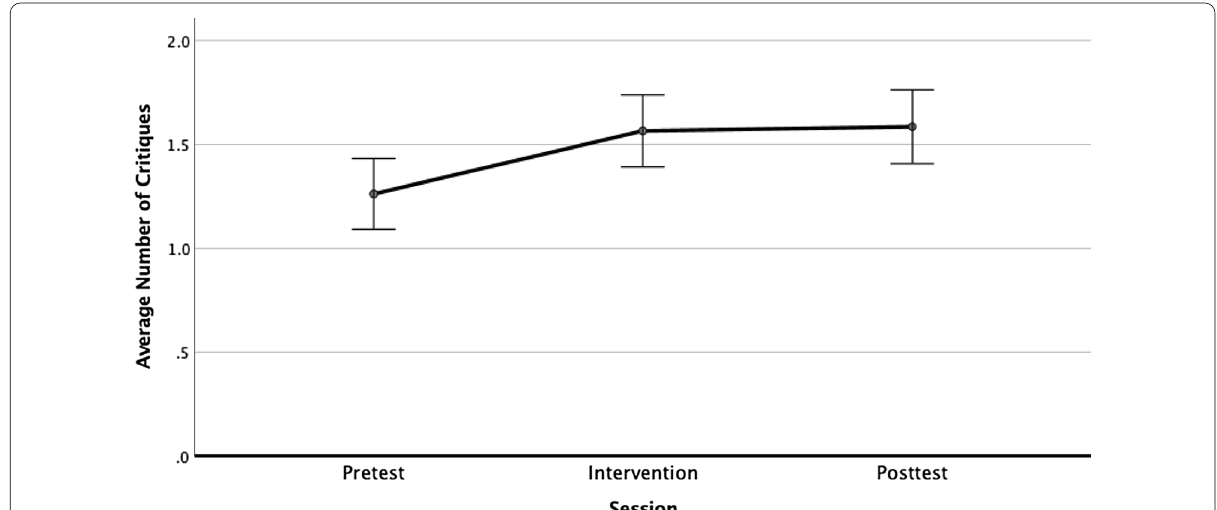
Fig. 2 Average number of critique reasons in students’ open-ended responses across sessions. Error bars represent within-subjects standard error of the mean (Cousineau, 2005)